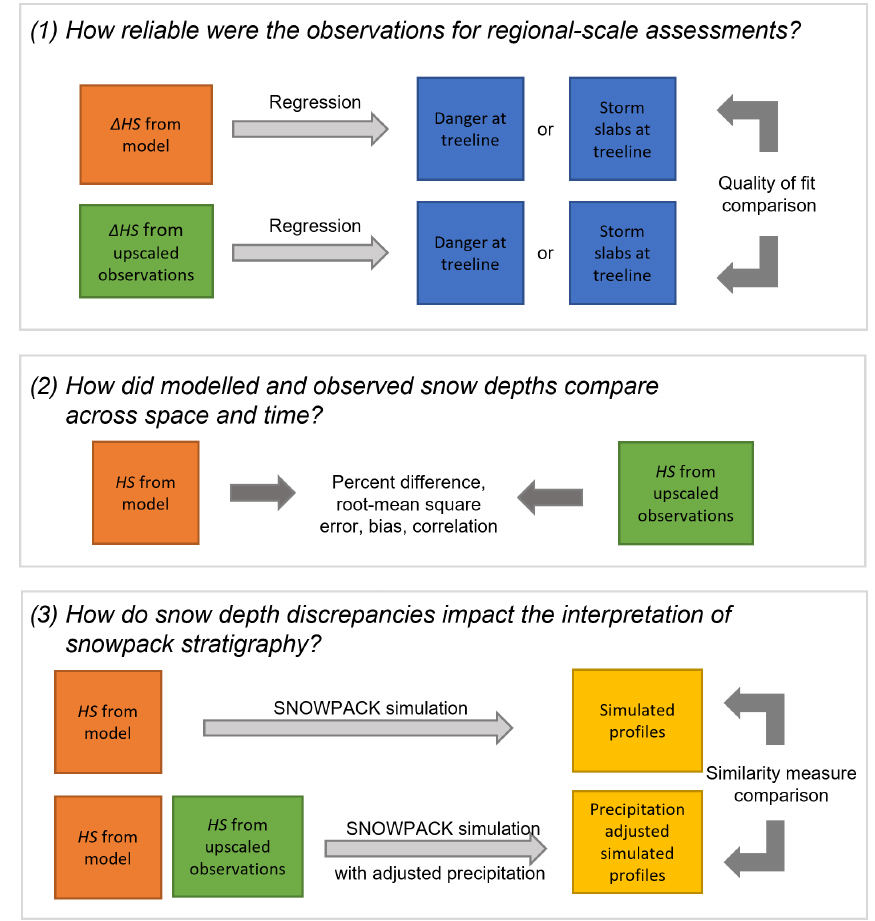
Figure 2. Methods used to analyse the reliability of the observations at regional scales, compare modelled and observed snow depths, and measure the impact of snow depth discrepancies on snowpack